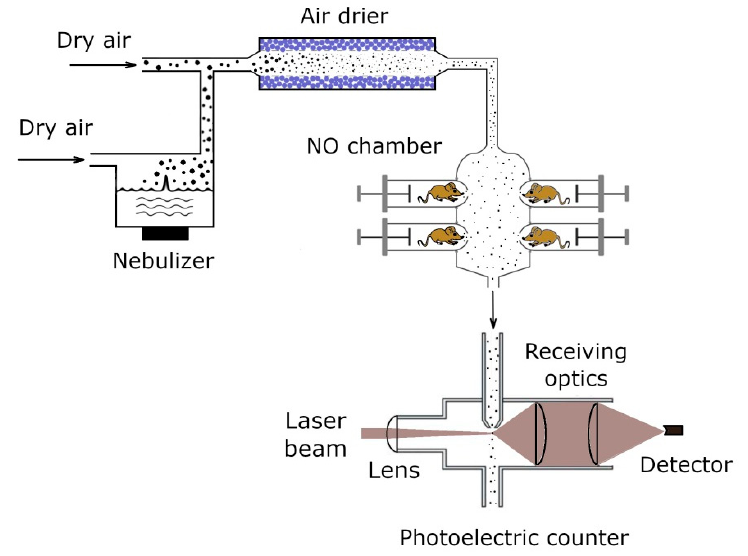
Figure 1. Schematic of the aerosol generation–inhalation equipment.